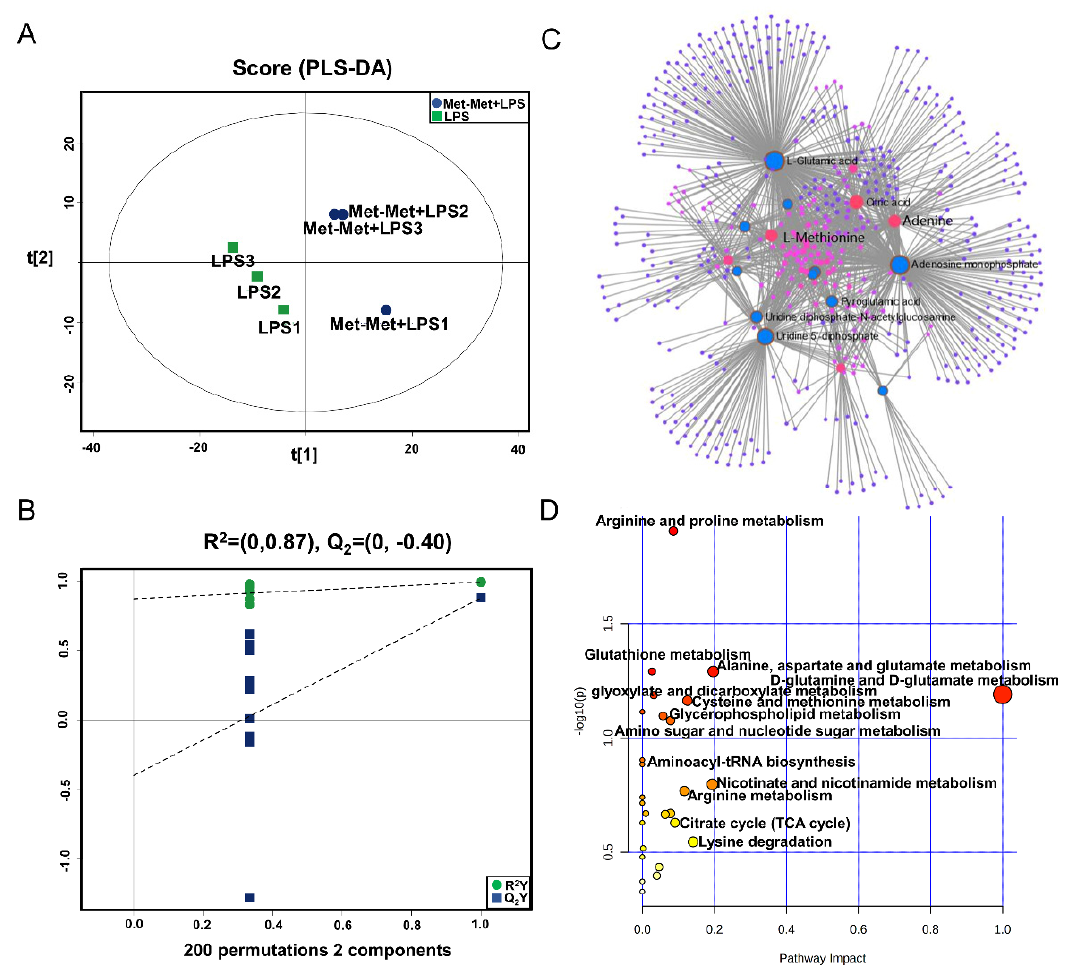
Figure 4. Met-Met altered the metabolic status of the inflammatory response. ( A ) The PLS-DA score plot of the Met-Met+LPS vs. LPS group. ( B ) Cross-validation plot of the PLS-DA model with 200 permutation tests in the Met-Met+LPS vs. LPS group. ( C ) Metabolite-metabolite interaction network of DMs in the comparative group of Met-Met+LPS vs. LPS. Node size represents the degree. Red and blue circles correspond to the increased and reduced DMs in the comparative group of Met-Met+LPS vs. LPS, respectively. ( D ) Pathway analysis of the DMs in the Met-Met+LPS and LPS groups. The X -axis and Y -axis indicate the pathway impact and the degree of pathway enrichment, respectively. A darker color indicates a higher degree of pathway enrichment, and a larger size indicates a higher pathway impact value. DMs: differential metabolites.